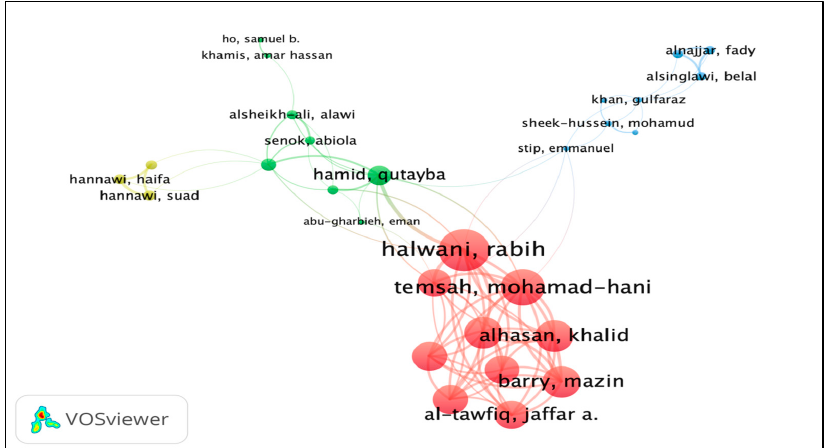
Figure 4. Co-authorship authors network visualization based on TLS. Different colors indicate different clusters, while the nodes indicate the contribution of an author, and the links represent the linkage/collaboration between authors. The bigger the node, the higher contribution of an author; the thicker the linkage/line, the stronger the collaboration between authors.